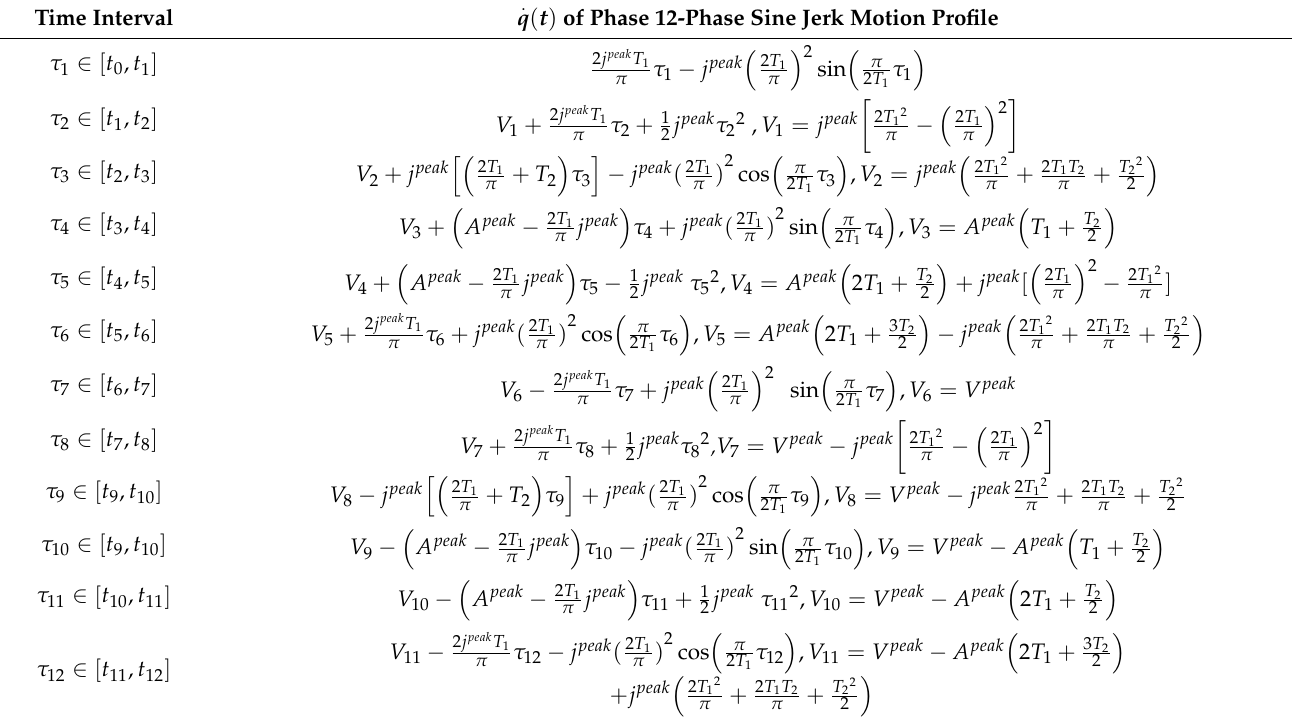
. q ( t ) , of phase 12-phase sine jerk motion profile. . q ( t ) of Phase 12-Phase Sine Jerk Motion